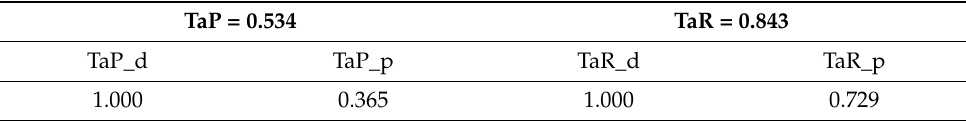
Table 11. Comparing performance metrics by